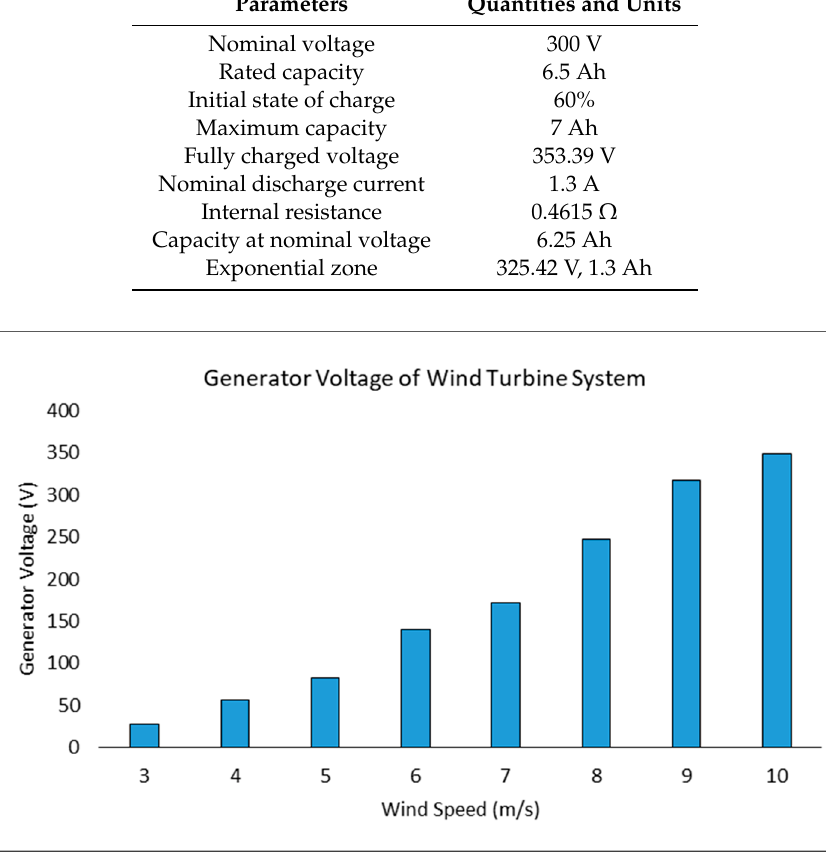
Figure 10. Generator voltage of wind-turbine system. Table 4. Parameters of battery.